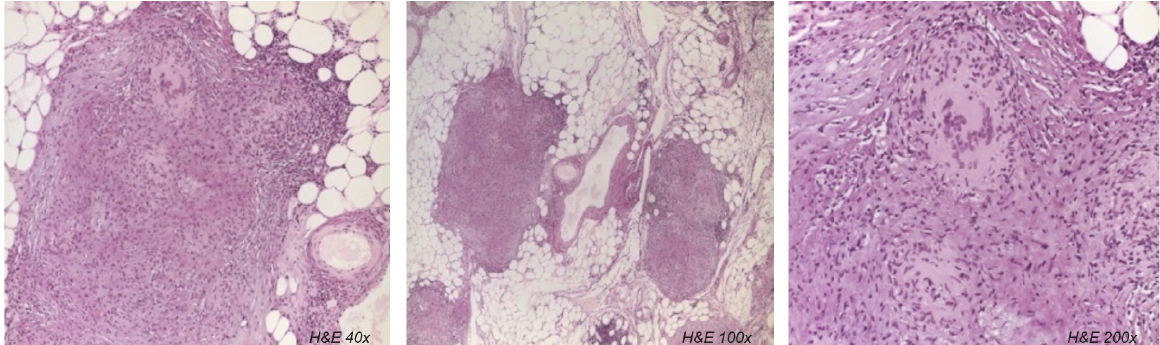
Figure 2: Histologic examination of mesenteric lesion: multiple and noncaseating granulomas with a predominantly perivascular distribution (Hematoxylin and Eosin stain, magnification x40, x100, and